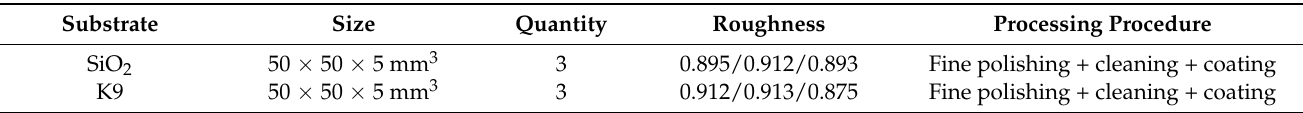
Table 1. Substrate information for complex spectral dielectric membrane elements.